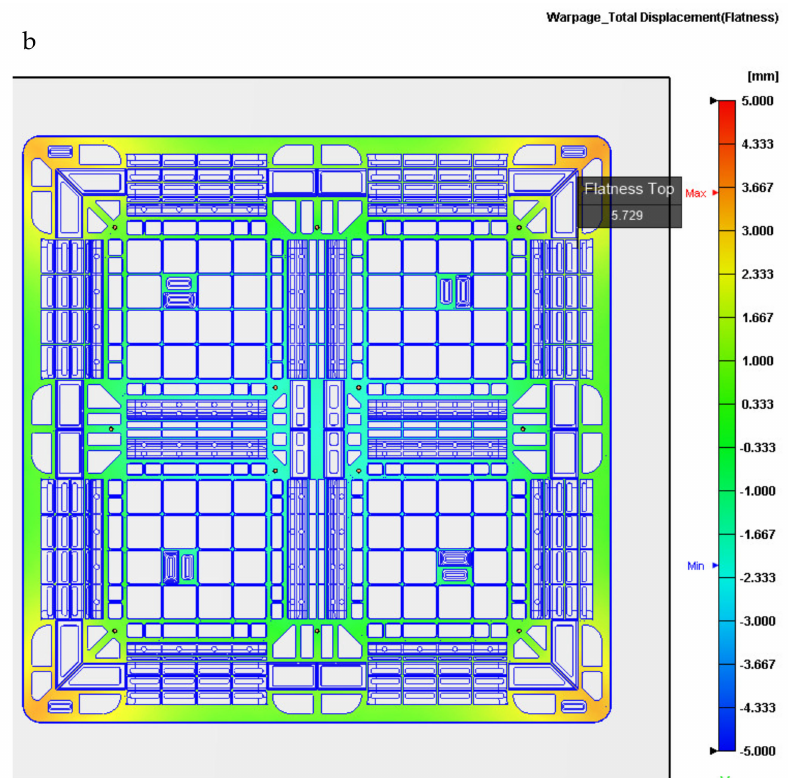
Figure 9. ( a ) Changes in the top height of the pallet measured by the ATOS system (flatness 5.144 mm); ( b ) changes in the top height of the pallet under the time control of 40 s of packing time (flatness 5.729 mm).